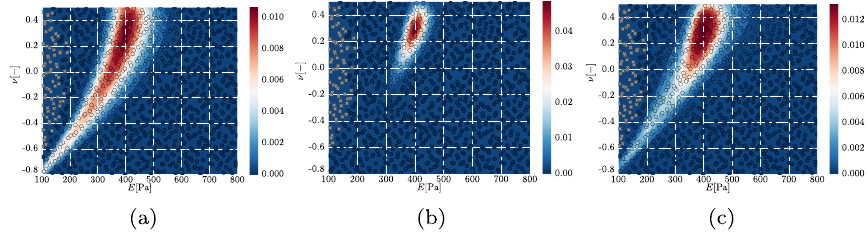
Fig. 5 Likelihoods for different surface measure distances with n train = 1000. a Euclidean distance at measurement points, b closest point projection distances, c RKHS norm. Normalized for better comparability. Training samples as circles for successful and gray crosses (on the left side) for failed forward model